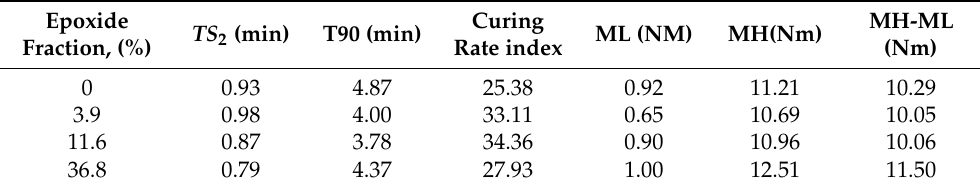
Figure 3. Curing curves of guayule natural rubber/epoxidized guayule natural rubber blend com- posites with various epoxide fractions. GNR 50CB: guayule natural rubber composites without epoxidation; 30EGNR 3.9% 70GNR 50CB: guayule natural rubber/epoxidized guayule natural rub- ber blend composites with 3.9% epoxide fraction; 30EGNR 11.6% 70GNR 50CB: guayule natural rubber/epoxidized guayule natural rubber blend composites with 11.6% epoxide fraction; 30EGNR 36.8% 70GNR 50CB: guayule natural rubber/epoxidized guayule natural rubber blend composites with 36.8% epoxide fraction. Table 3. TS 2 , T90, Curing rate index, minimal torque (ML), maximal torque (MH) and difference between maximal and minimal torque (MH-ML) of guayule natural rubber/epoxidized guayule natural rubber blend composites at various epoxide